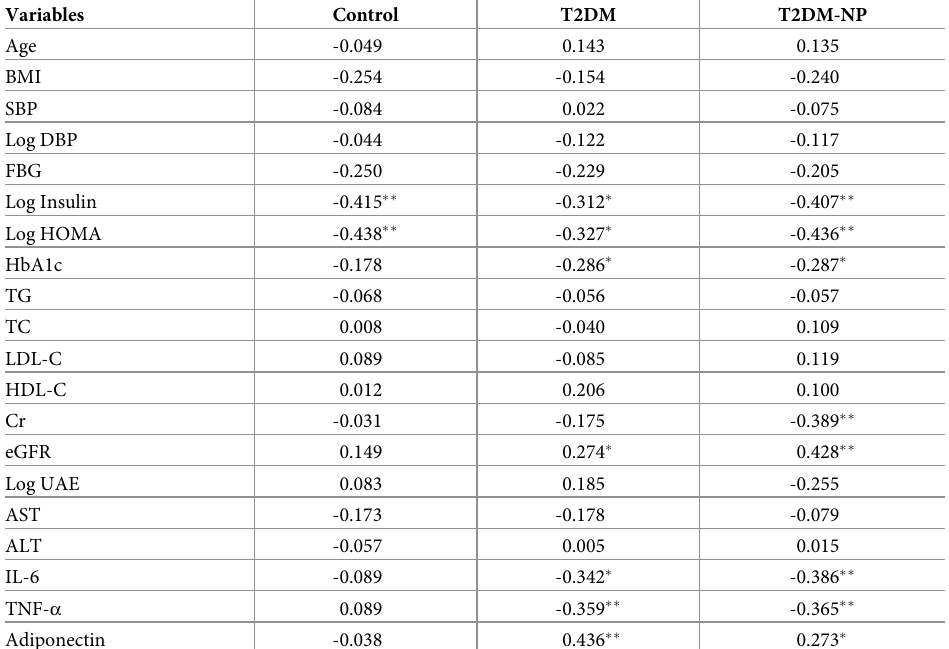
Table 3. Correlation of CTRP3 with anthropometric and biochemical variables in the studied groups. Variables